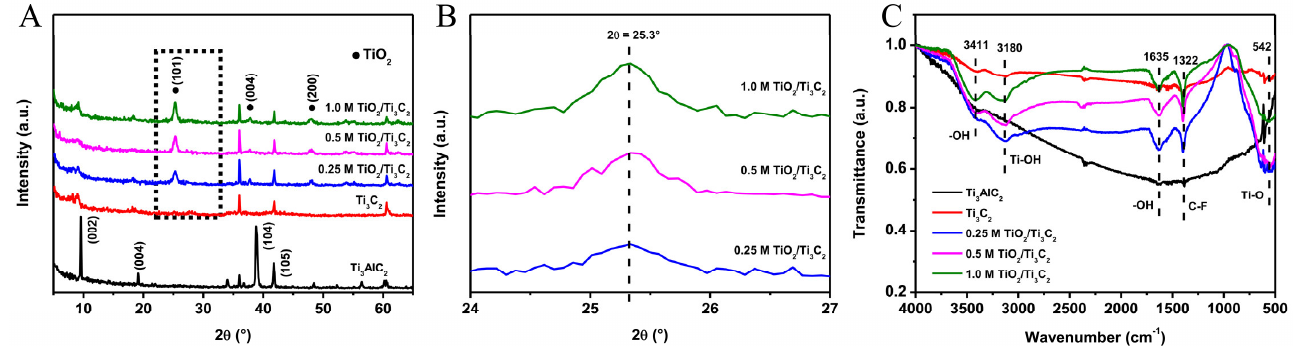
Figure 2. XRD patterns ( A , B ) and FTIR spectra ( C ) of Ti 3 AlC 2 , Ti 3 C 2 , and TiO 2 /Ti 3 C 2 .